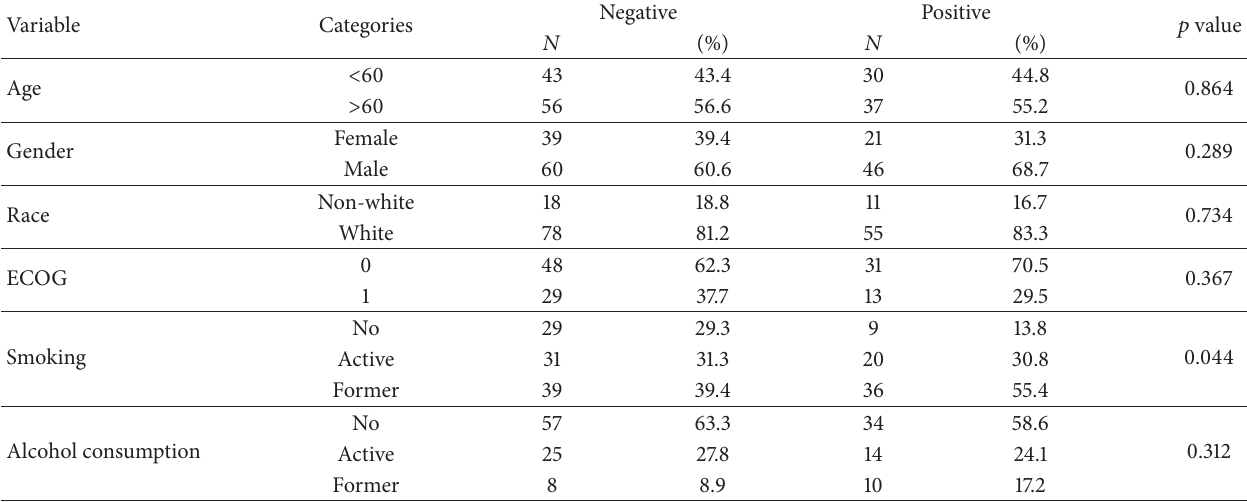
Table 6: PD-L1 expression in tumor cells and demographic data.